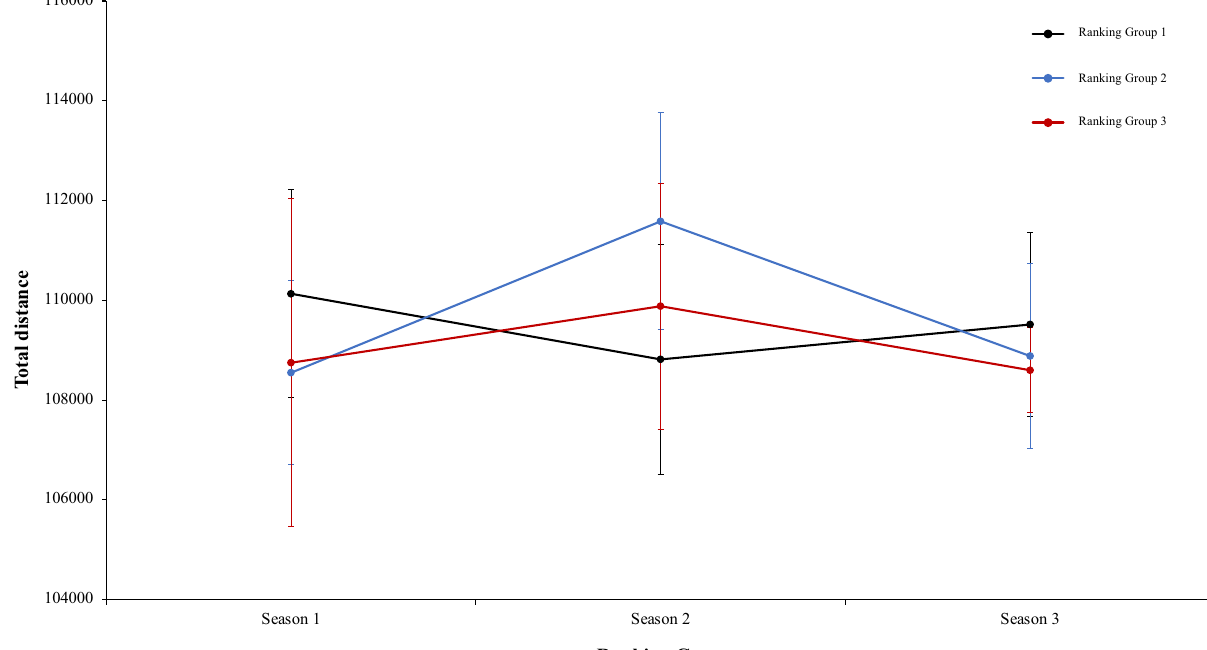
Figure 5. Physical performance. Mean TD (± SE) as a funtion of Ranking and Season